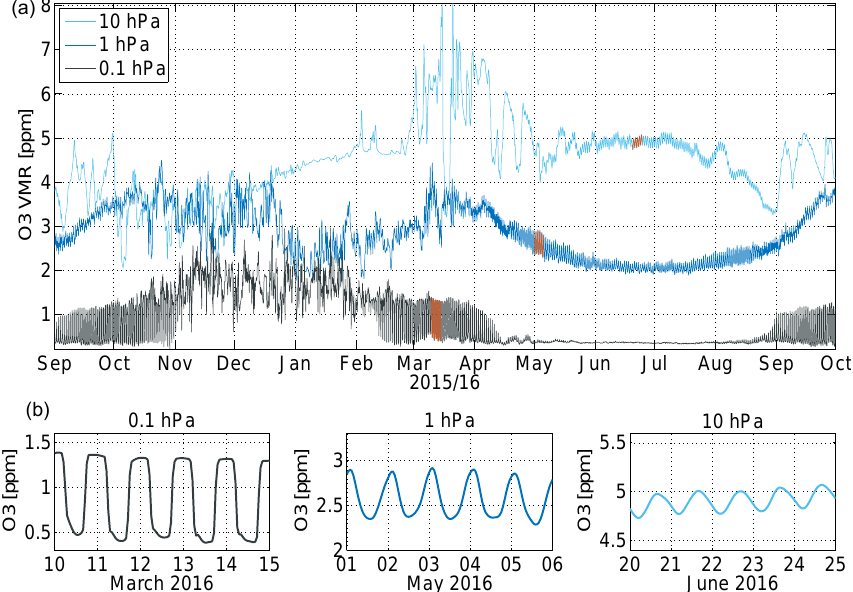
Figure 8. Ozone volume mixing ratio simulated by SD-WACCM at Ny-Ålesund over the course of 1 year and at three pressure levels (a) . The red intervals indicate the periods for the zoomed-in view of the diurnal variations (b) . Over 1 year the altitude of a fixed pressure level changes. In winter the pressure levels correspond to 28, 44 and 60km altitude and in summer to 32, 50 and 67km